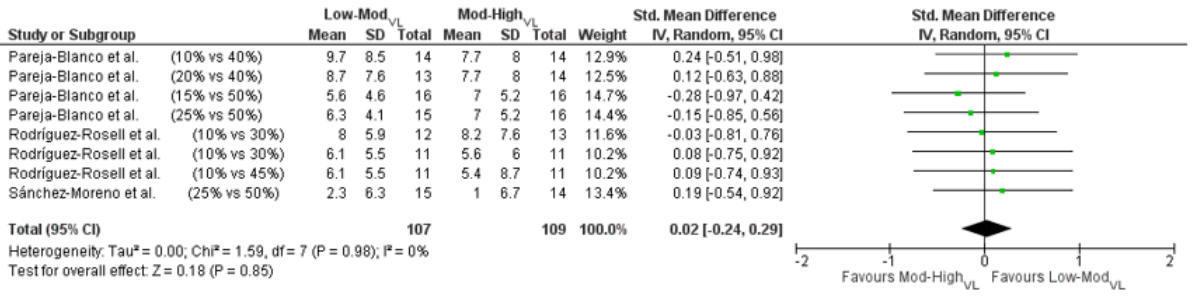
Figure 5. Between-group analysis comparing the effects of Low-Mod VL (≤25% intra -set VL) and Mod-High VL (>25% intra- set VL) to promote changes in local muscle endurance. Green squares: ES Figure 4. Between-group analysis comparing the effects of Low-Mod VL (≤25% intra -set VL) and for each individual comparison; Black diamond: pooled ESs. Sánchez-Moreno et al. [31]; Pareja- Mod-High VL (>25% intra-set VL) to promote changes at low loads (absolute loads lifted faster than Figure 2. Between-group analysis comparing the effects of Low-Mod VL (≤25% intra -set VL) and Blanco et al. [35,36]; Rodríguez -Rosell et al. [34,40]. Figure 4. Between-group analysis comparing the effects of Low-Mod VL ( ≤ 25% intra-set VL) and 1.00 m·s −1 and 0.80 m·s −1 at pre- training in the squat and bench press exercises, respectively, ≤ 60% Mod-High VL (>25% intra-set VL) to promote changes in 1RM. Green squares: ES for each individual Mod-High VL (>25% intra-set VL) to promote changes in 1RM. Green squares: ES for each individual 1RM [35,36]). Green squares: ES for each individual comparison; Black diamond: pooled ESs. comparison; Black diamond: pooled ESs. Sánchez-Moreno et al. [31,33]; Pareja-Blanco et al. [35–38]; comparison; Black diamond: pooled ESs. S á nchez-Moreno et al. [31,33]; Pareja-Blanco et al. [35–38]; Sánchez-Moreno et al. [31]; Pareja- Blanco et al. [35,36,38]; Rodiles -Guerrero et al. [39]; Rodríguez- Rodiles-Guerrero et al. [39]; Rodríguez-Rosell et al. [34,40]. Rodiles-Guerrero et al. [39]; Rodr í guez-Rosell et al. [34,40]. Rosell et al. [34,40].